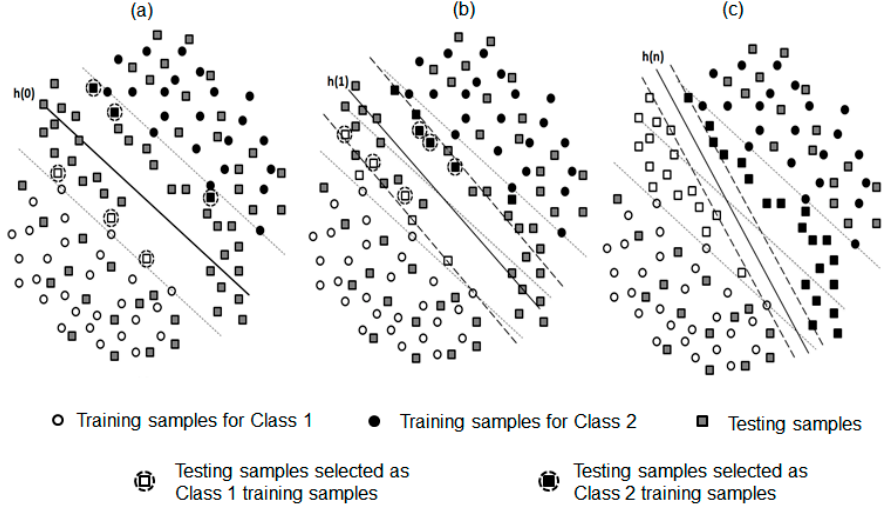
Figure 5. Concept of the TSVM adaptive algorithm for a binary classification problem. Classification hyperplane h (solid line) and margin bounds (dashed lines) in a two-dimentional feature space were shown at the ( a ) first iteration, ( b ) second iteration, and ( c ) last iteration. The dashed circles highlighted the testing samples selected as training data for Class 1 and Class 2, which were called transductive data.